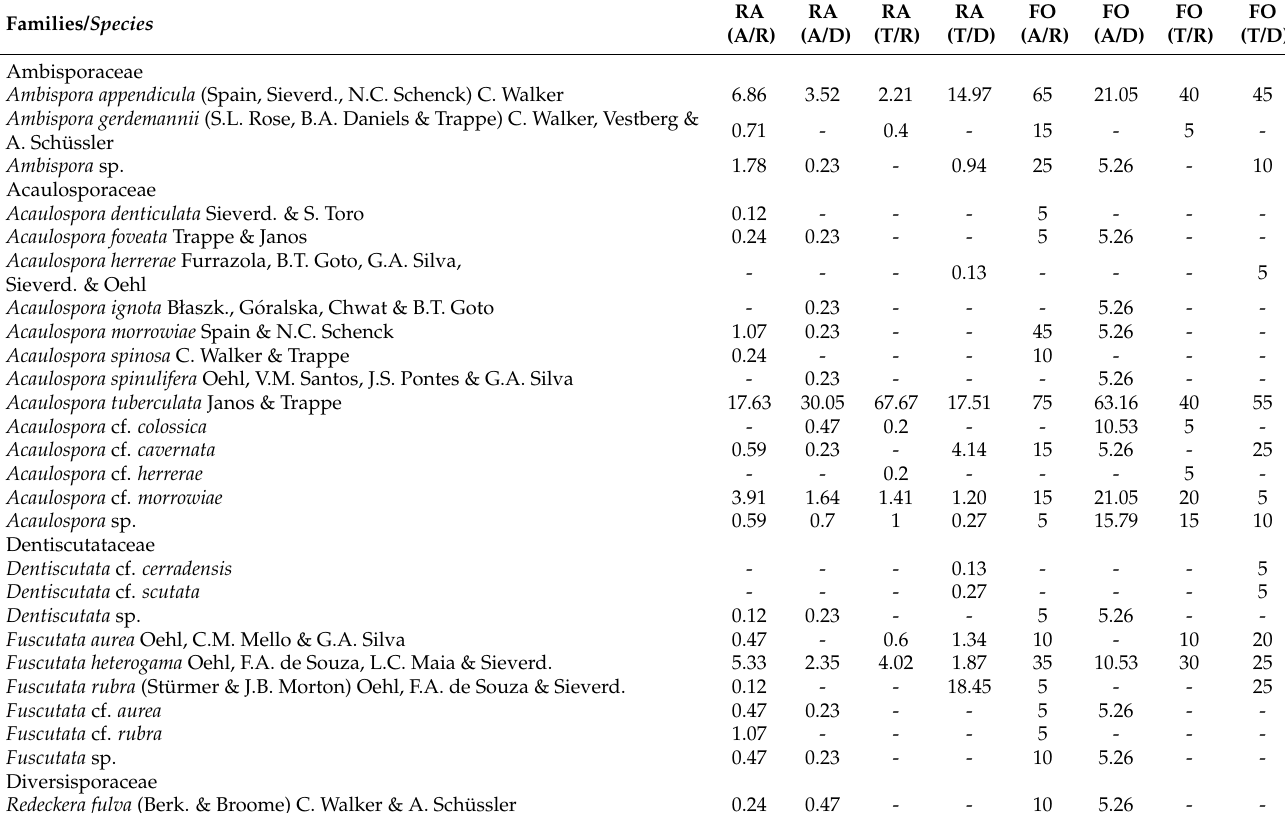
Table 1. AMF species in an aquatic-terrestrial gradient and their respective relative abundances (RA%) and frequencies of occurrence (FO%) in an interdune oligotrophic lagoon of coastal restinga in